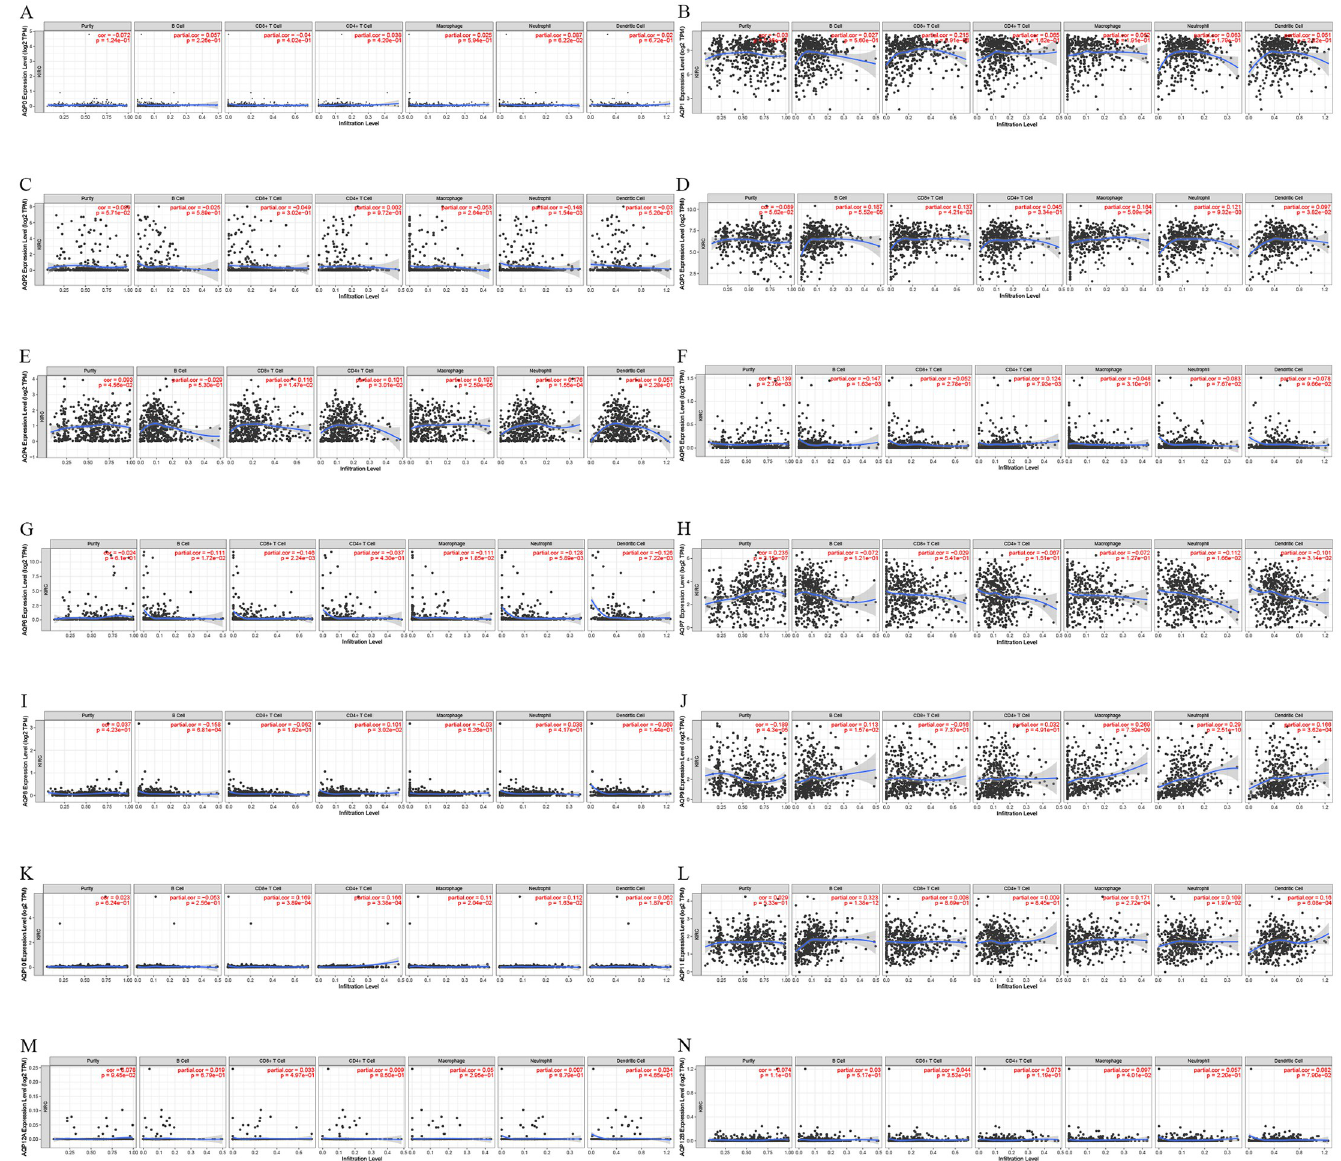
Fig 7. Correlations of B cells, CD8+T cells, CD4+T cells, macrophages, neutrophils, dendritic cells and AQPs in ccRCC (TIMER). Correlations of mRNA expression levels between cell markers of B cells, CD8+T cells, CD4+T cells, macrophages, neutrophils, dendritic cells and AQPs in ccRCC patients were shown. The ‘partial cor’ indicated the purity-corrected partial Spearman’s rho value, and the ‘p’ referred to ‘p-value’ (p-value < 0.05 was